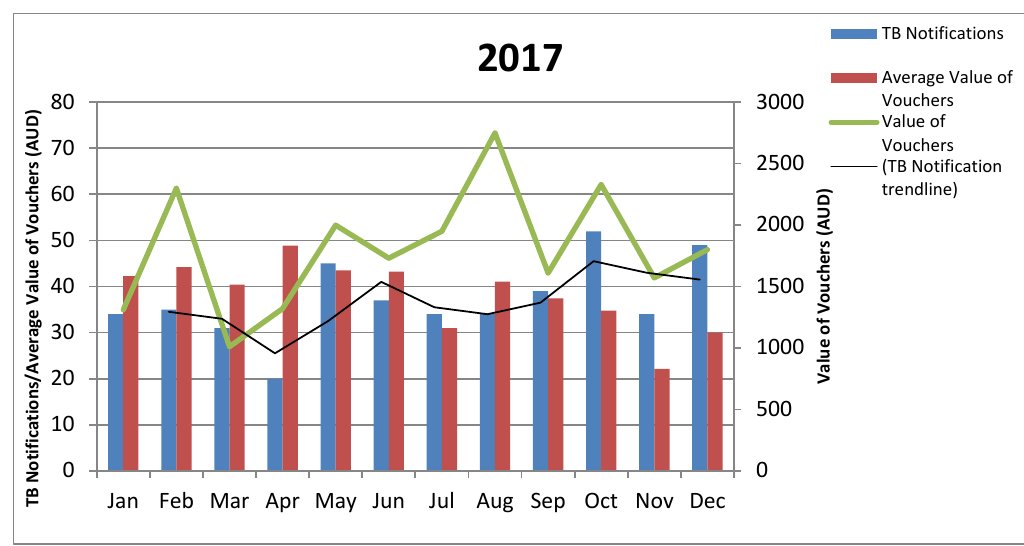
Figure 3. Value of Vouchers Provided by Month, 2017.